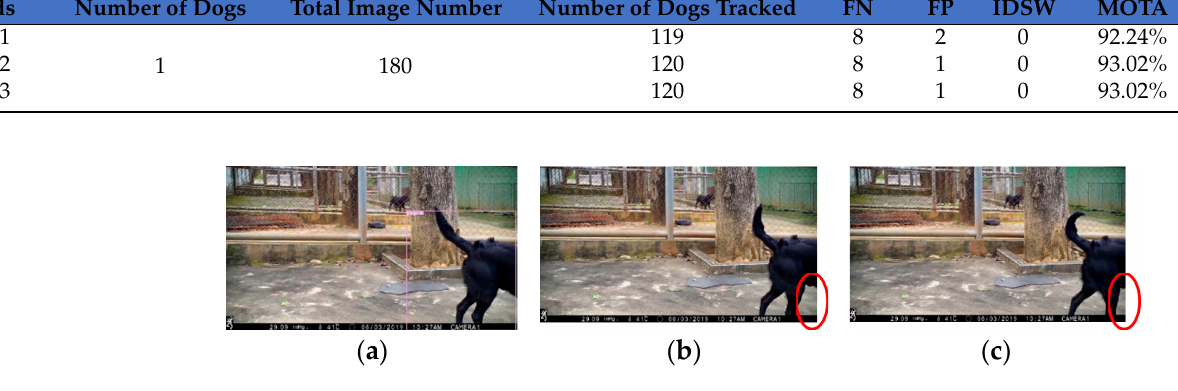
Table 14. Results of dog tracking experiments conducted using IMG_0014